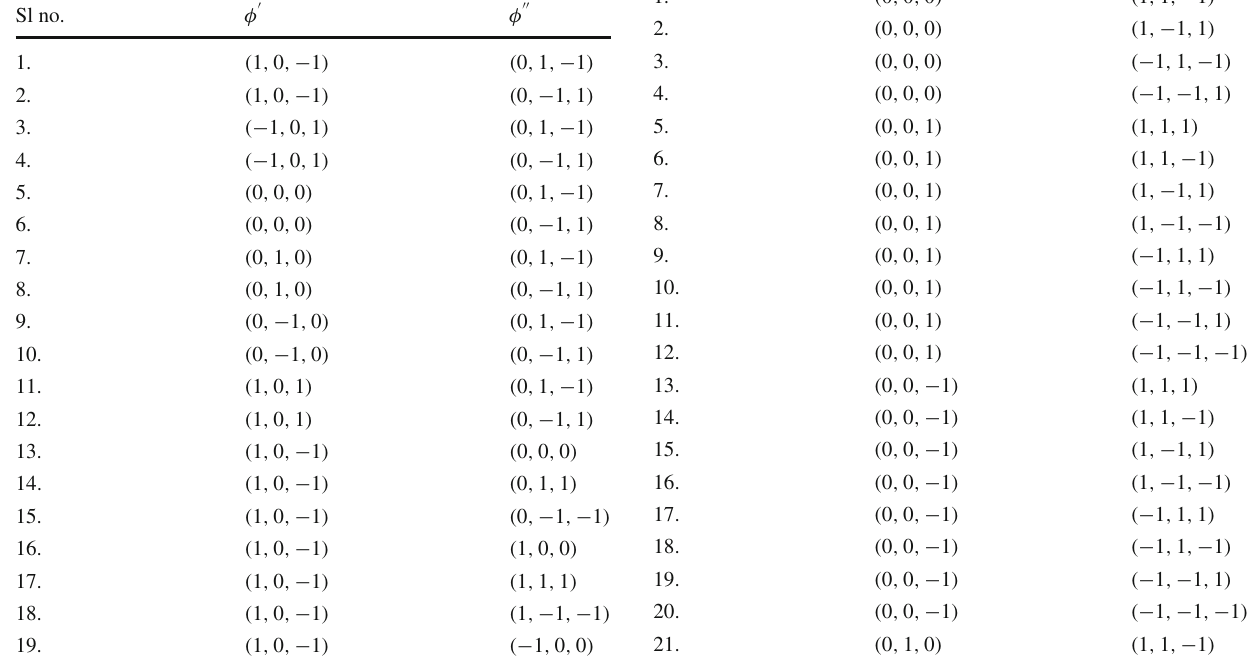
Table 9 (μ − τ) symmetry (in 3 × 3